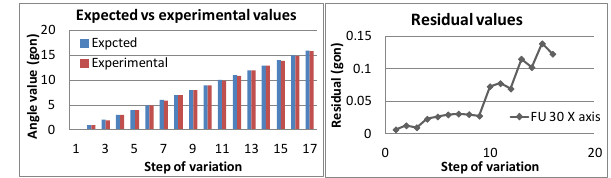
Figure 9. Tilt values one axis x mode Expected versus experimental values (left) residual (rigth)